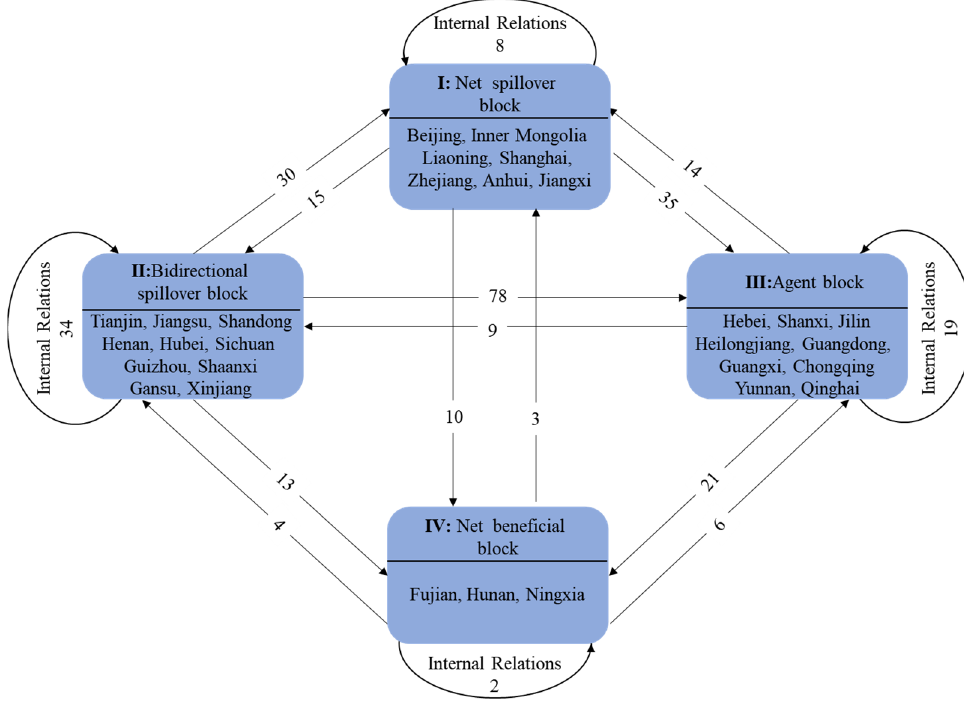
Figure 10. Spatial correlation between the four blocks.